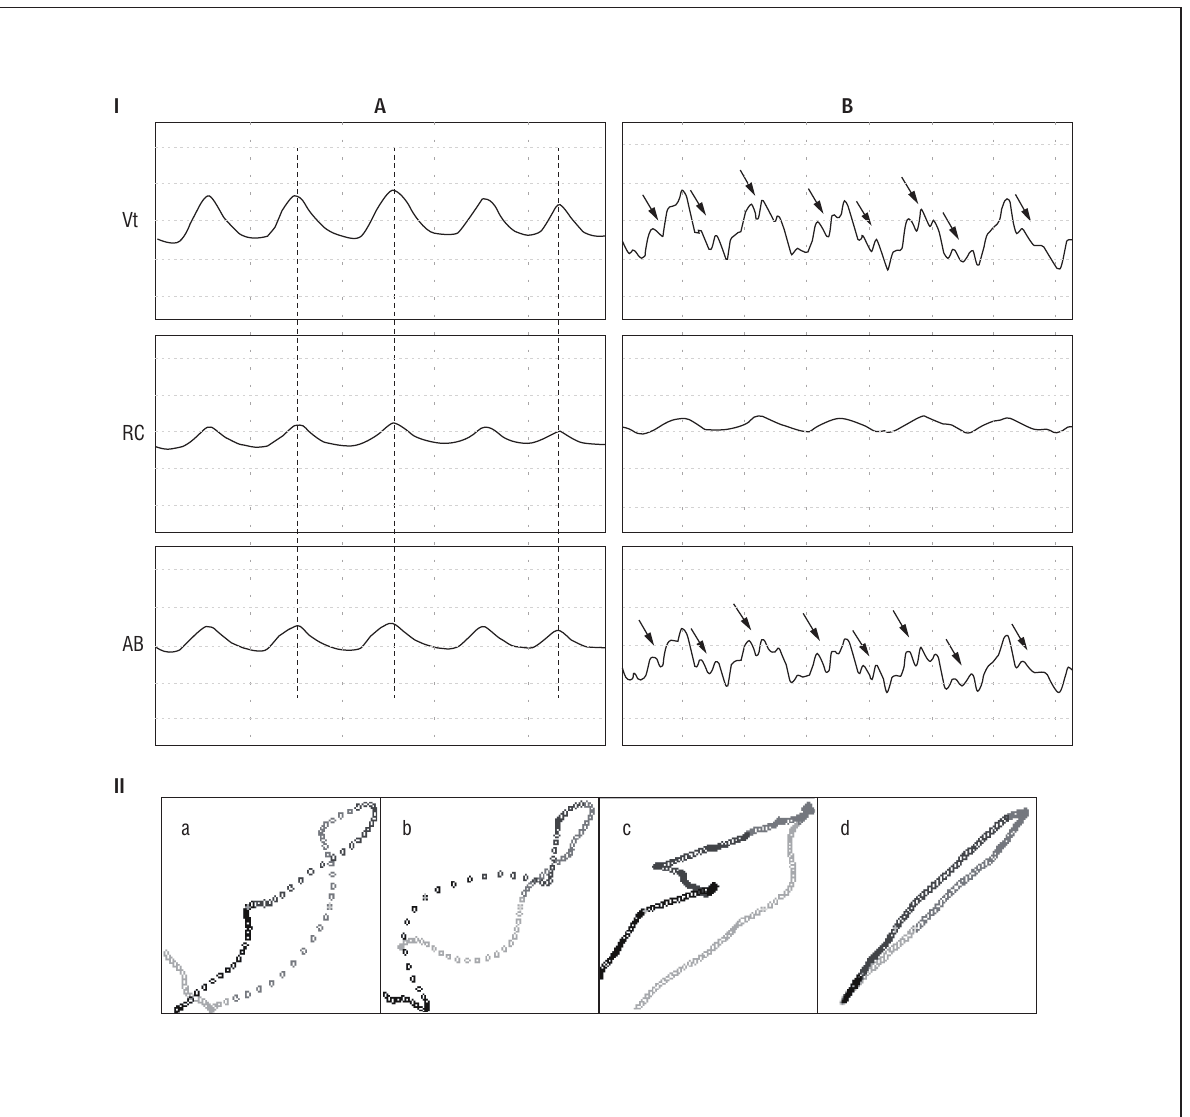
Figure 1 - Example of typical waveforms at rest (A) and during exercise (B) on panel I, and Konno-Mead loops with "8 figure" (a, b and c) and without "8 figure" (d) on panel II Source: Research